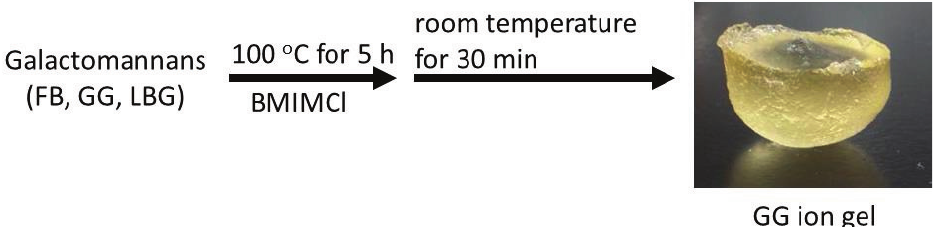
Figure 12. Procedure for fabrication of galactomannan ion gels with